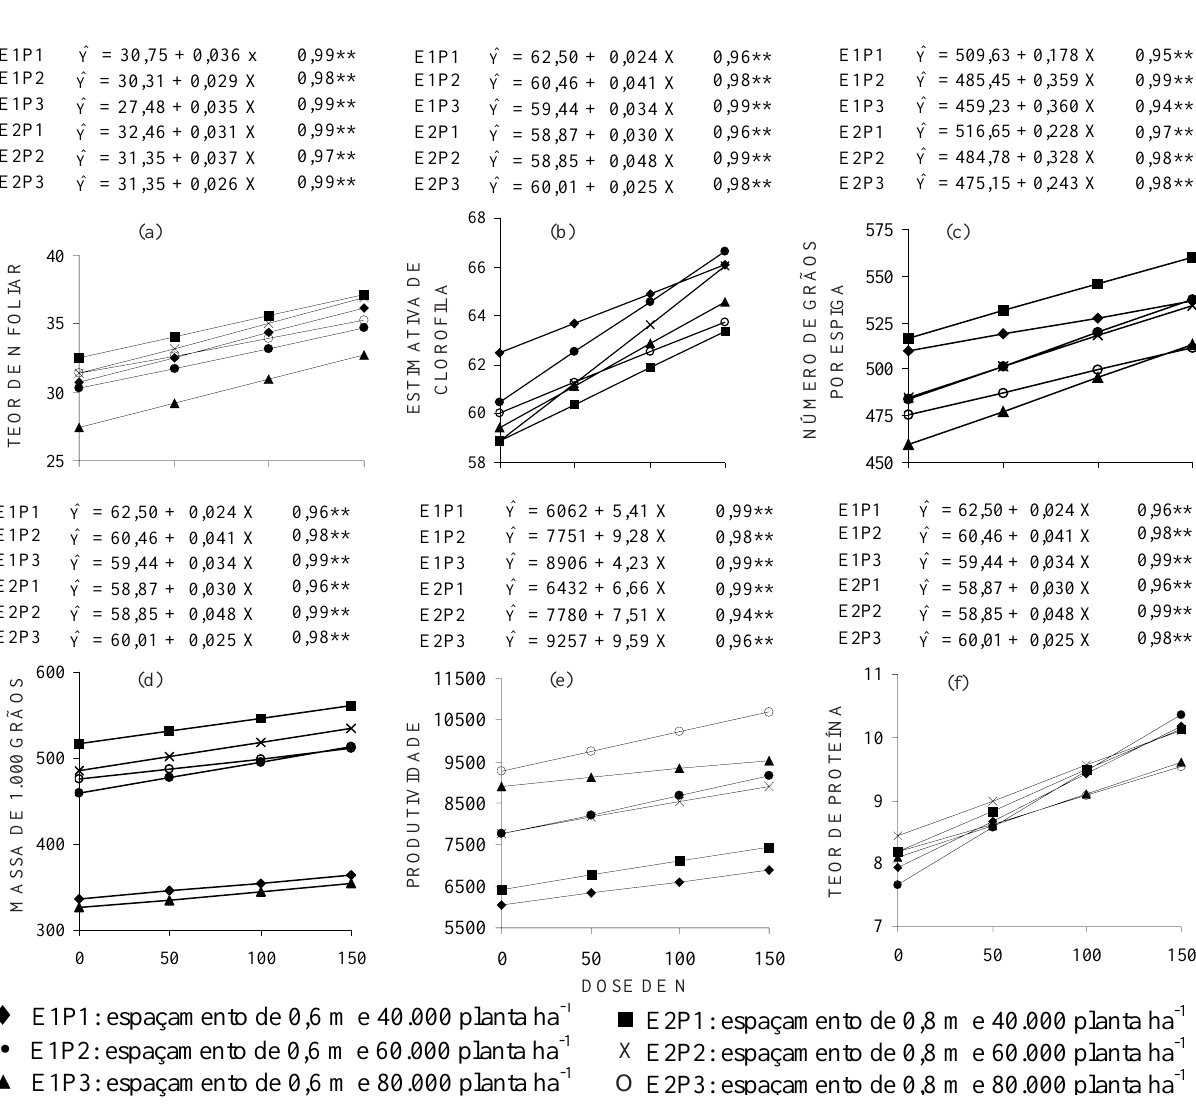
Figura 1. Teor de nitrogênio foliar (a); estimativa de clorofila (b); número de grãos por espiga (c); massa de 1.000 grãos (d); produtividade de grãos (e) e teor de proteína nos grãos (f) de milho submetido a diferentes arranjos populacionais e doses de